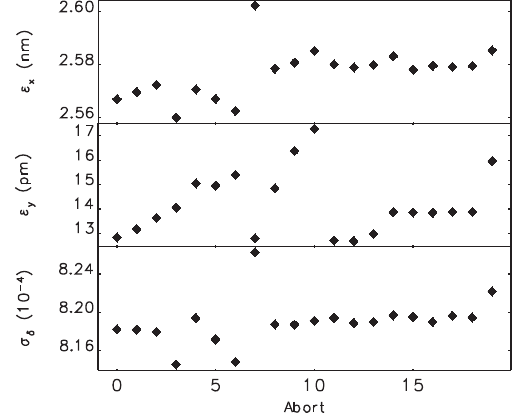
map.FIG. 4. Simulated equilibrium beam parameters for the second collimator experiment, from particle tracking simulations with PELEGANT . The horizontal axis label, “ Abort ” refers to the sequence number of the beam dumps (see Table